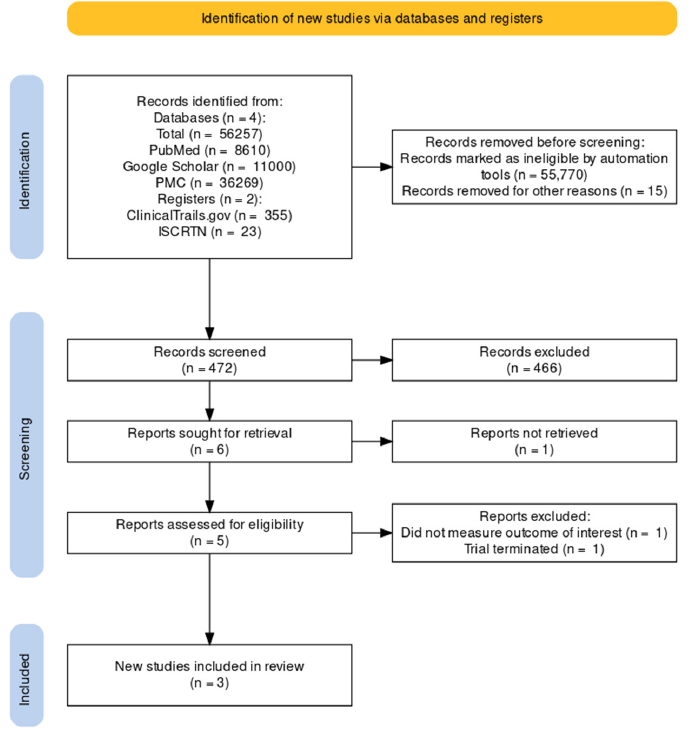
Figure 1. PRISMA flowchart.